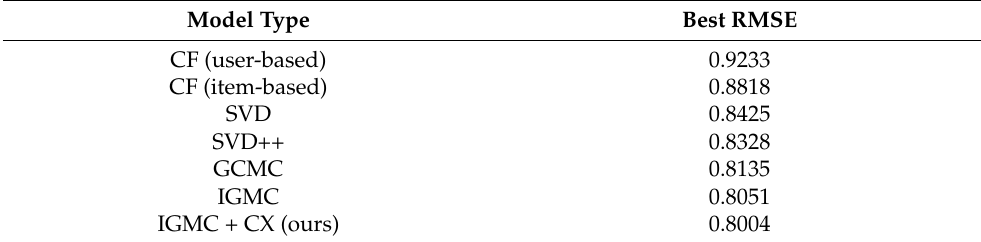
Table 1. RMSE Table of Rotten Tomatoes